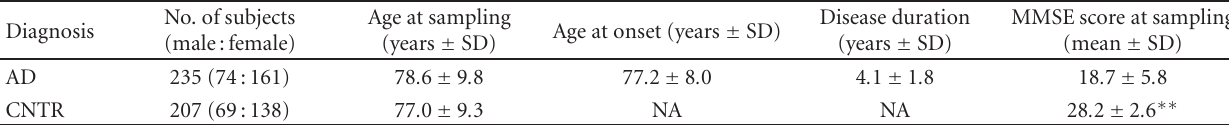
Table 2: Demographics of the AD